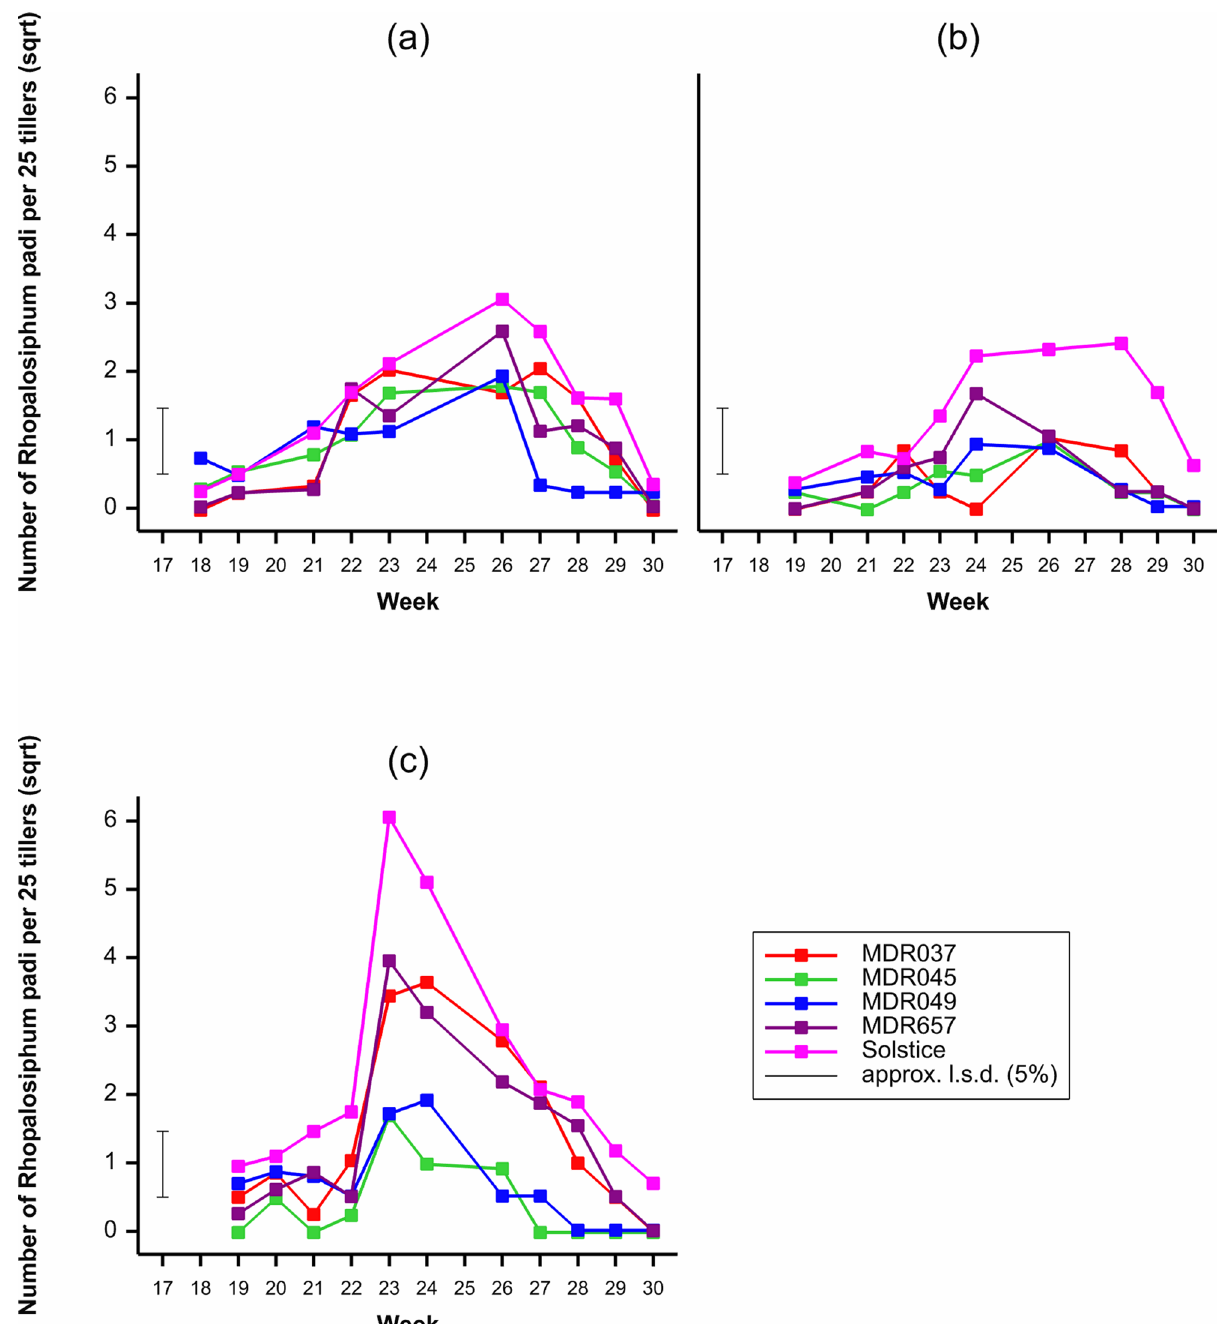
Figure 1. Average number of Rhopalosiphum padi, per 25 tillers observed on Triticum aestivum Solstice, Triticum moncoccum MDR037, MDR657, MDR045 and MDR049 in field trial ( a ) Year 1 (2017), ( b ) Year 2 (2018), ( c ) Year 3 (2019) from week 18 to week 30. All data was subject to square root